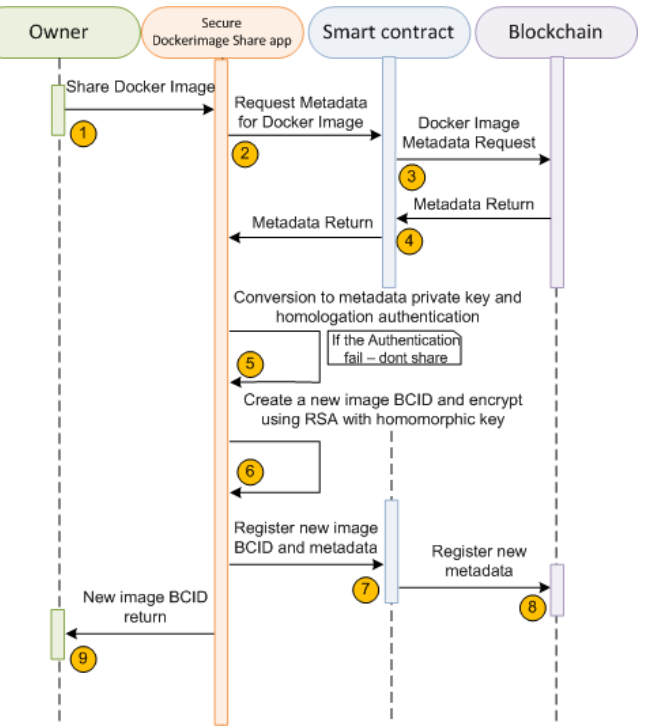
Figure 3. Sequence flow of the secure docker image share.